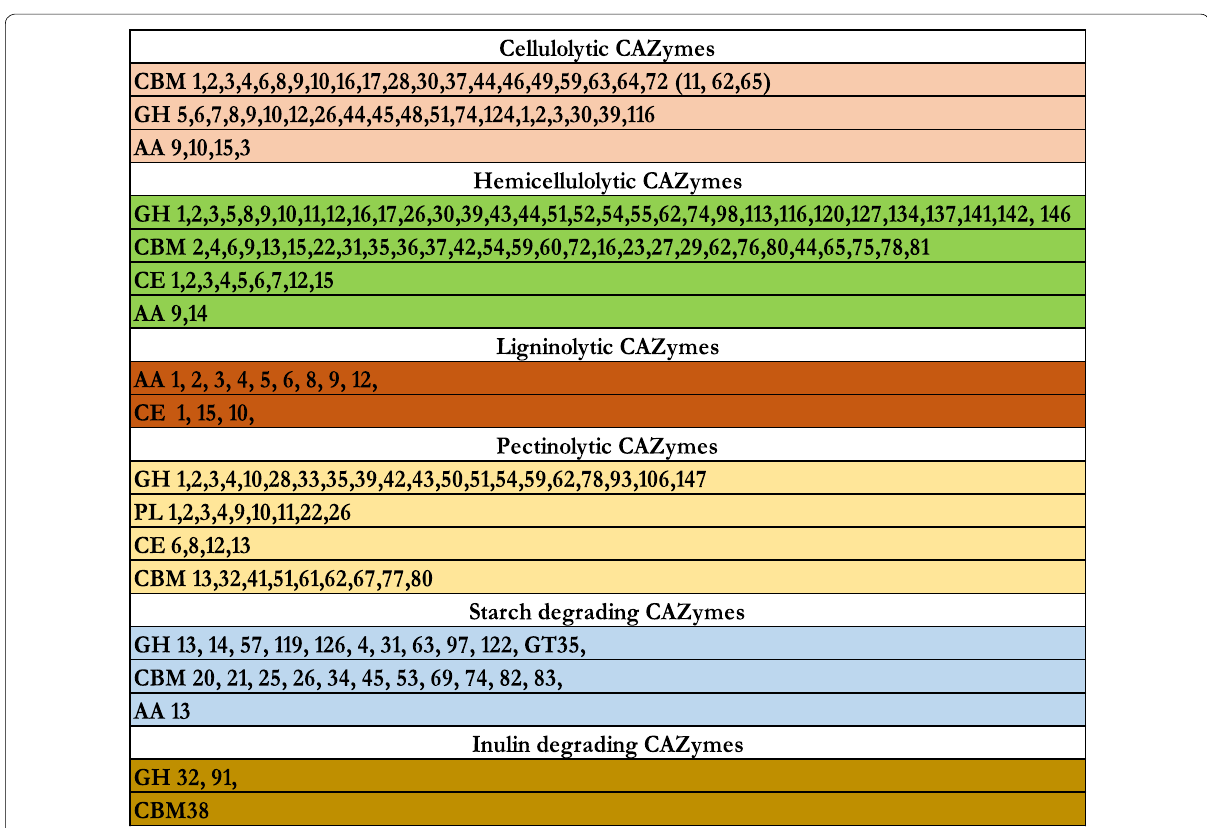
Fig. 2 Illustration of CAZy groups and classes involved in degradation of (a) cellulose, (b) hemicellulose, (c) lignin, (d) pectin, (e) starch and (f) inulin. For e.g., in CBRF web-database: cellulose degrading ability function calculates all the cellulose degrading CAZymes present in a given selected fungi and sorts all the fungi based on the number of cellulolytic